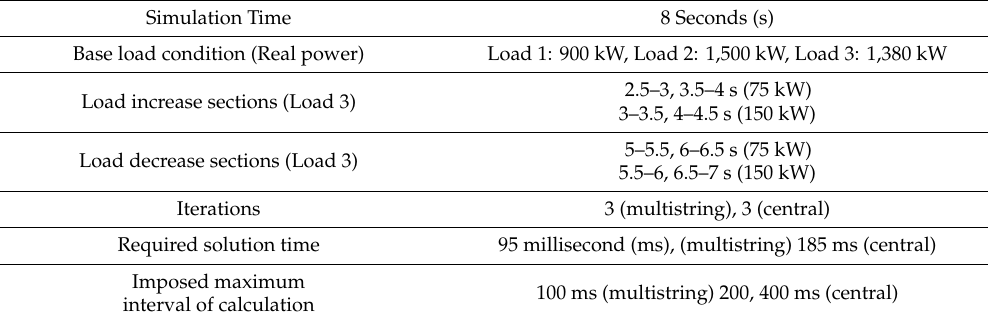
Table 3. Simulated case study description.